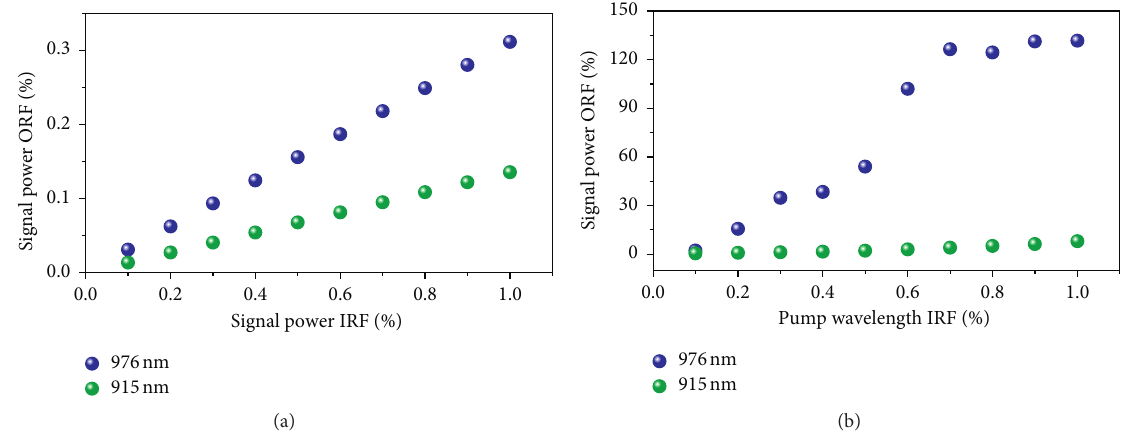
Figure 5: Simulated ORF of the signal power from the fiber amplifier versus the IRF of (a) signal power and (b) pump wavelength, with respect to the pump wavelength of 976 nm (blue) and 915nm